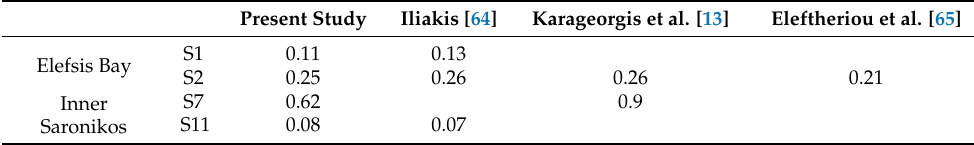
Table 2. Sedimentation rates (cm/y) in Elefsis Bay and the Inner Saronikos Gulf. Present Study Iliakis [64] Karageorgis et al. [13] Eleftheriou et al.